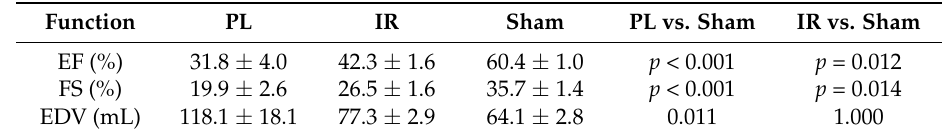
Table 1. Cardiac function 28 days after operations.